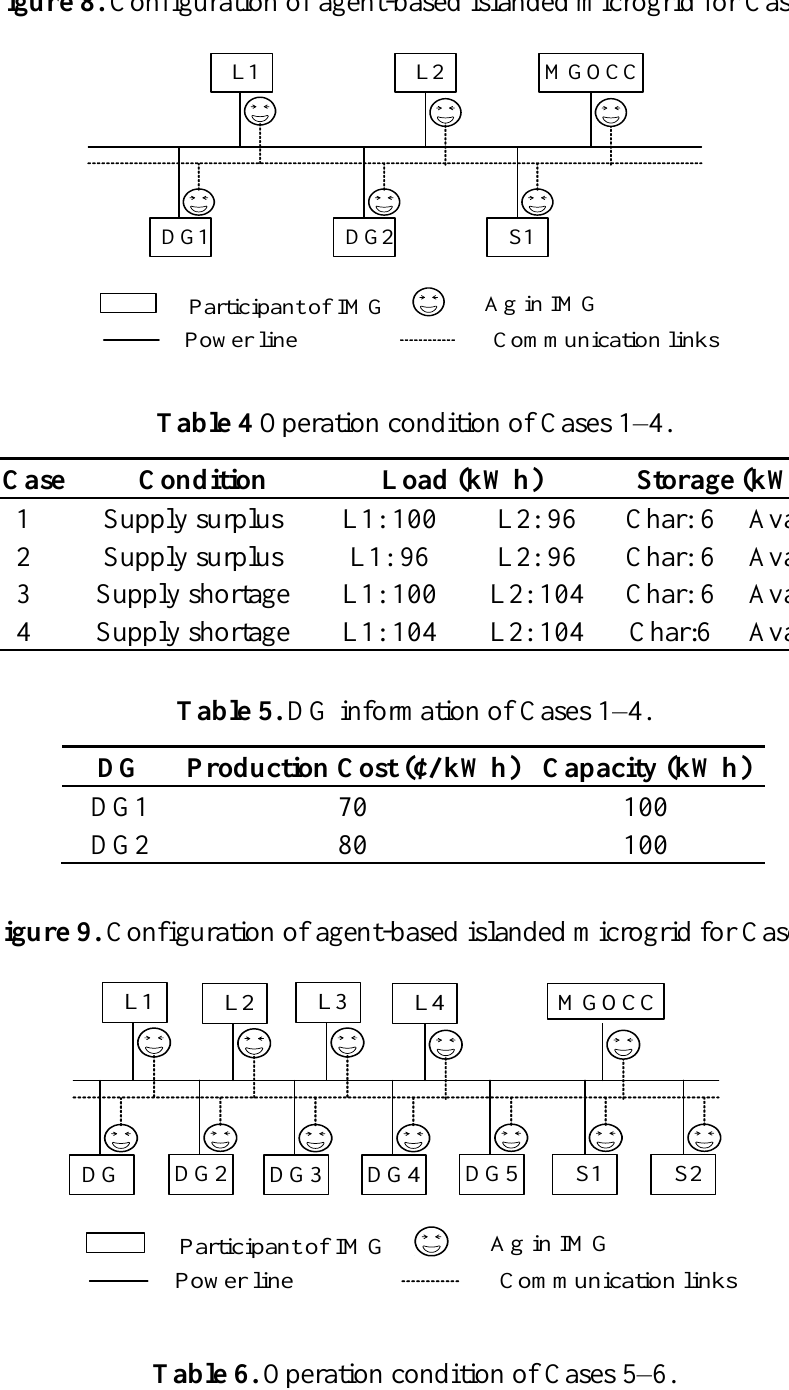
Figure 8. Configuration of agent-based islanded microgrid for Cases 1–4.